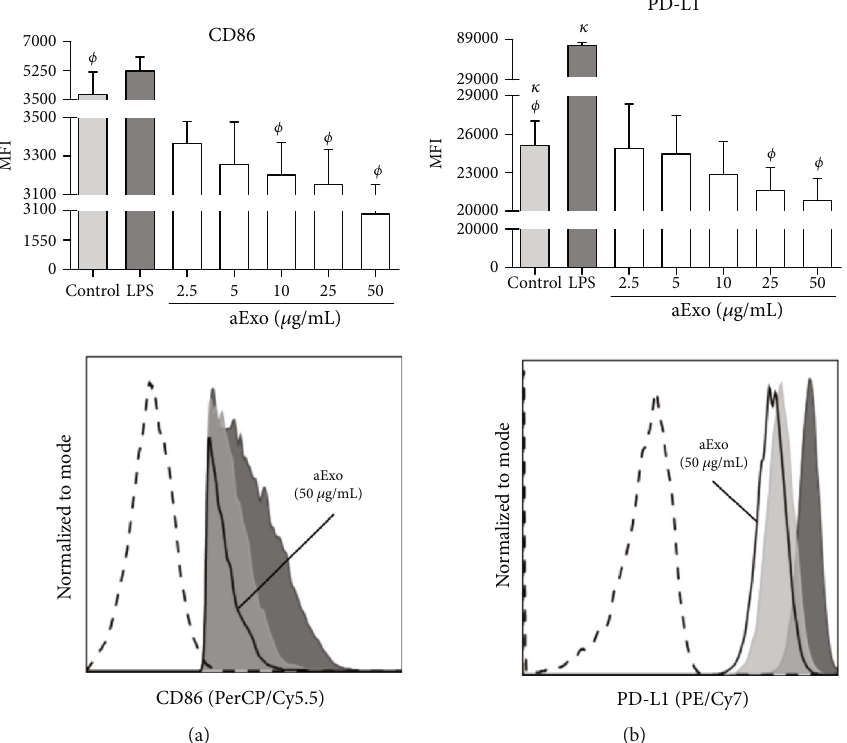
Figure 6: aExo of L. mexicana downregulate CD86 and PD-L1 expressions on iBMMs. Infected BMMs were incubated with aExo (2.5, 5, 10, 25, and 50 μ g/mL) for 24h. Cells were stained with mAbs anti-CD86 and anti-PD-L1. Controls: nonstimulated control and control of iBMMs incubated with LPS. (a) CD86 expression. (b) PD-L1 expression. Top panel displays a bar graph of MFI ± SD ( n = 5 ). Statistically signi fi cant di ff erences were determined using Mann – Whitney U test; p < 0 : 05 was considered signi fi cant, compared to control group. Bottom panels show representative histograms of molecule expressions. Nonstimulated iBMMs (gray fi lled histograms), positive control (black fi lled histograms), and iBMMs stimulated with 50 μ g/mL of aExo (black line) are shown. Unstained control is shown in black dashed